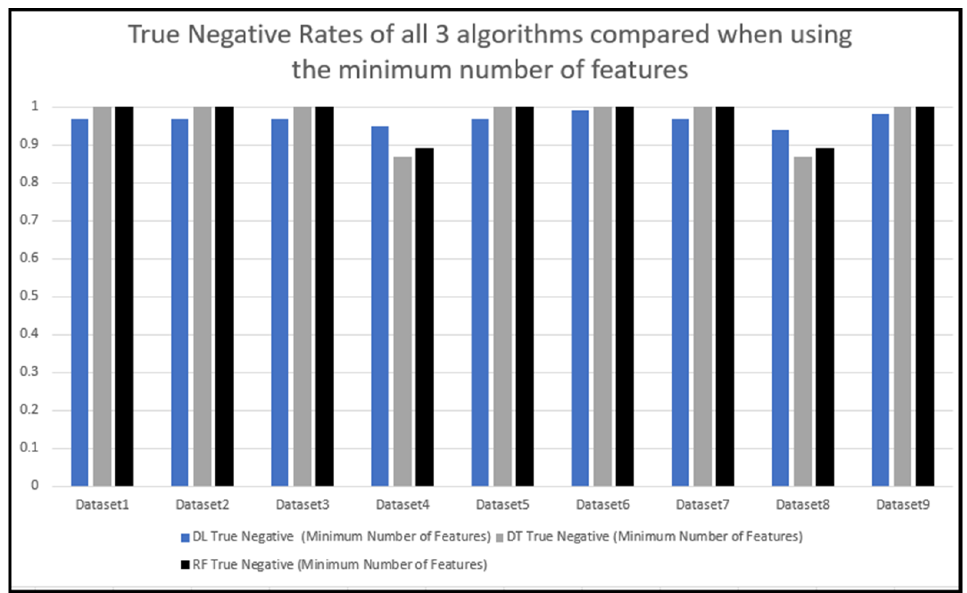
Figure 15. True positive rates compared for all three algorithms when using the minimum number of features.